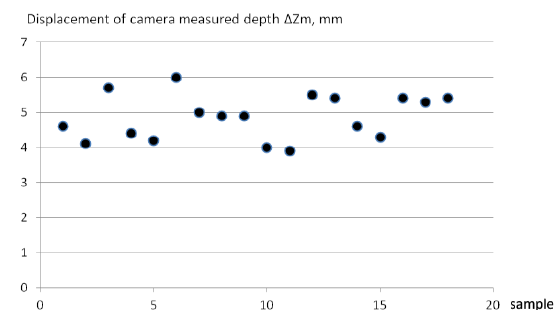
Fig. 10. Δ Z m camera measured depth of all measured samples.